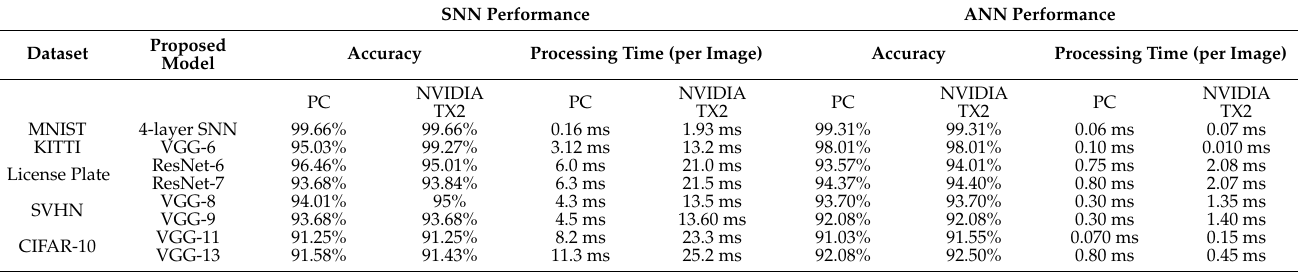
Table 7. Processing time and inference accuracy of different datasets on PC and NVIDIA JETSON TX2. SNN Performance ANN